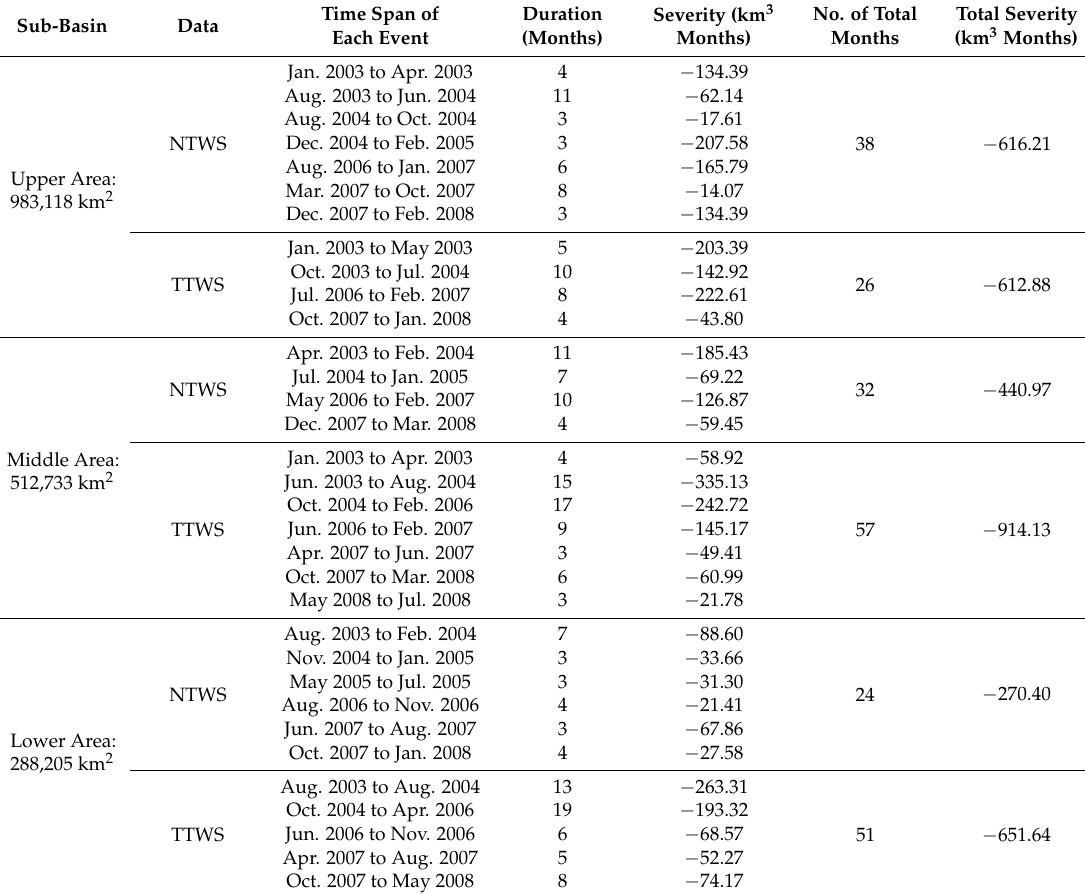
Table 4. The frequency, duration, and severity of hydrological drought in the upper, middle, and lower sub-basins of the YRB from 2003 to 2008 based on the NTWS and the